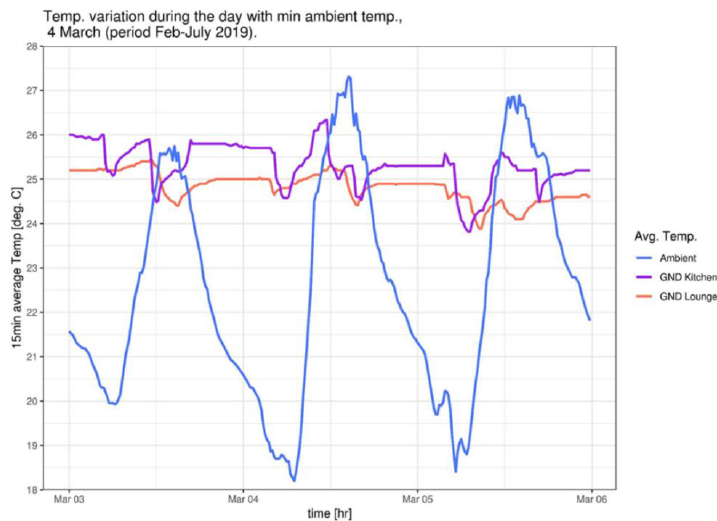
Figure 9. Temperature variation during the day with the min. ambient temperature (4 March) in the measurement period from February to July